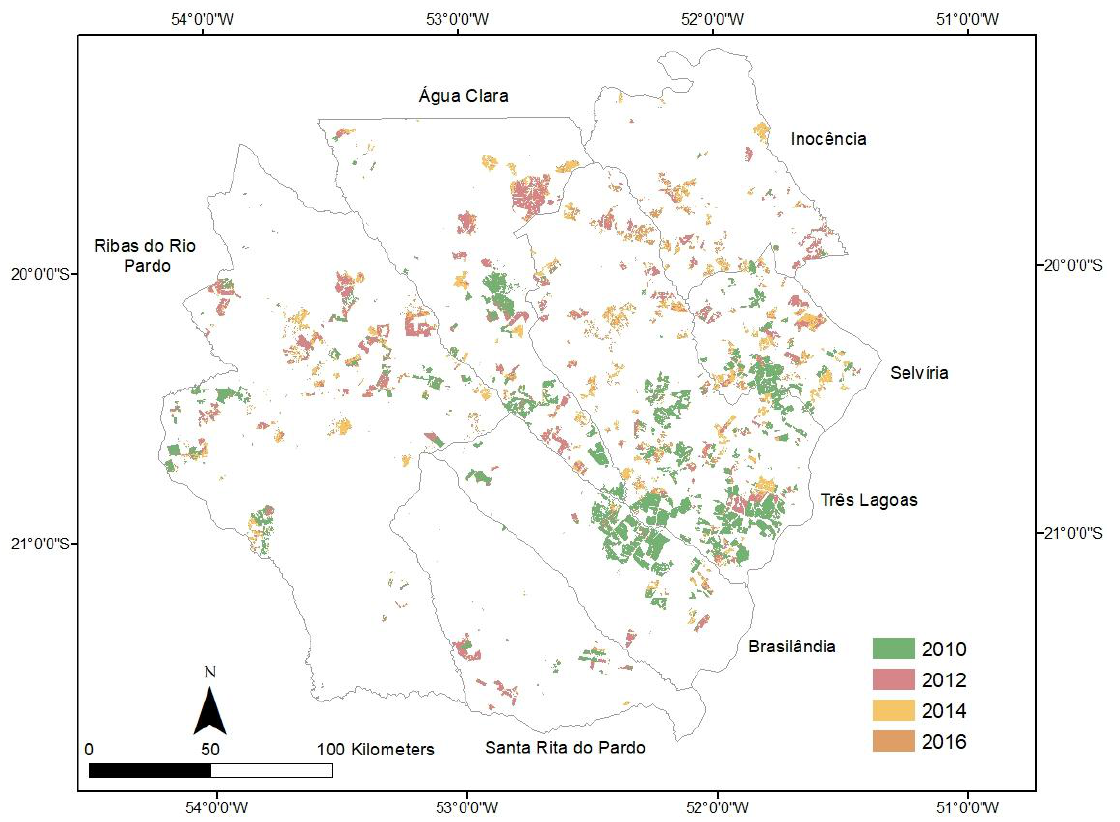
Figure 2. Eucalyptus plantation expansion areas across Brazilian savanna by year over the study period (2010 to 2016).